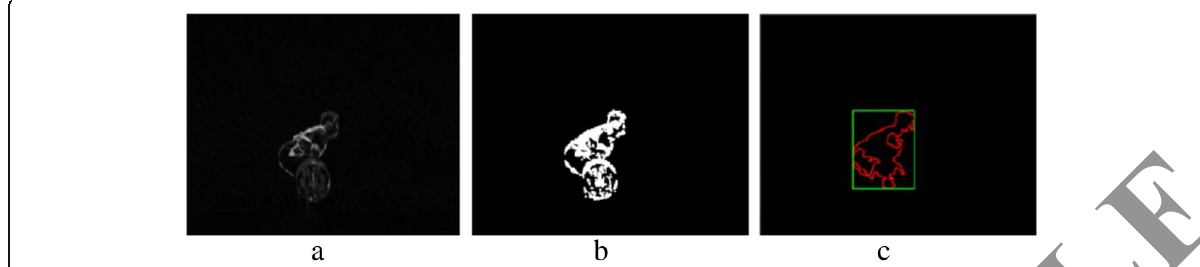
Fig. 3 Inter-frame difference method. a Grayscale image. b Binarization image. c Edge image after split inspection